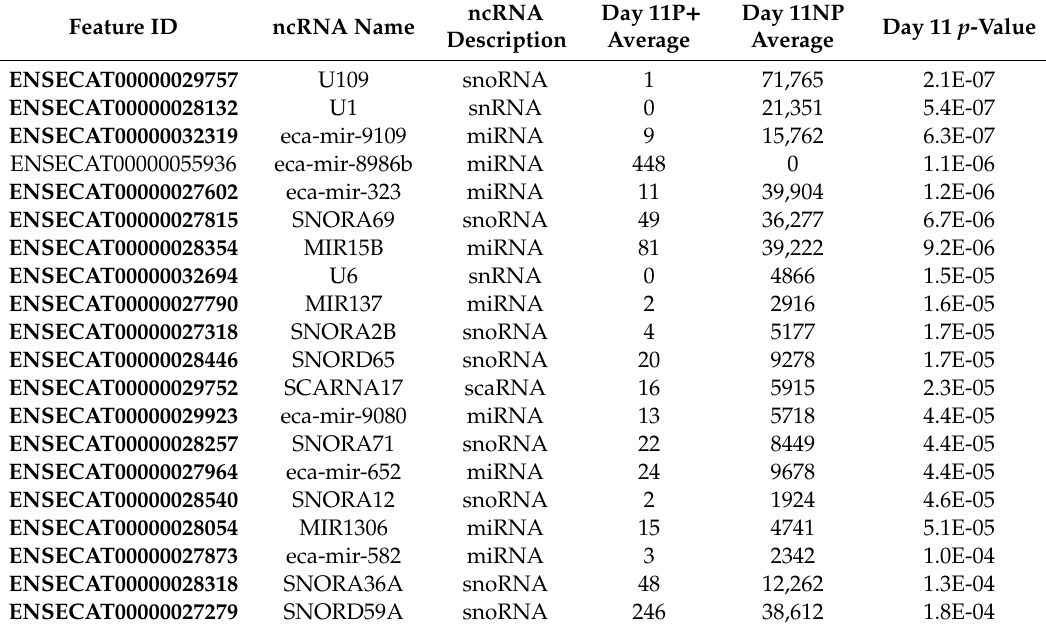
Table 1. Top 20 di ff erentially expressed non-coding RNA in the endometrium on day 11 with known